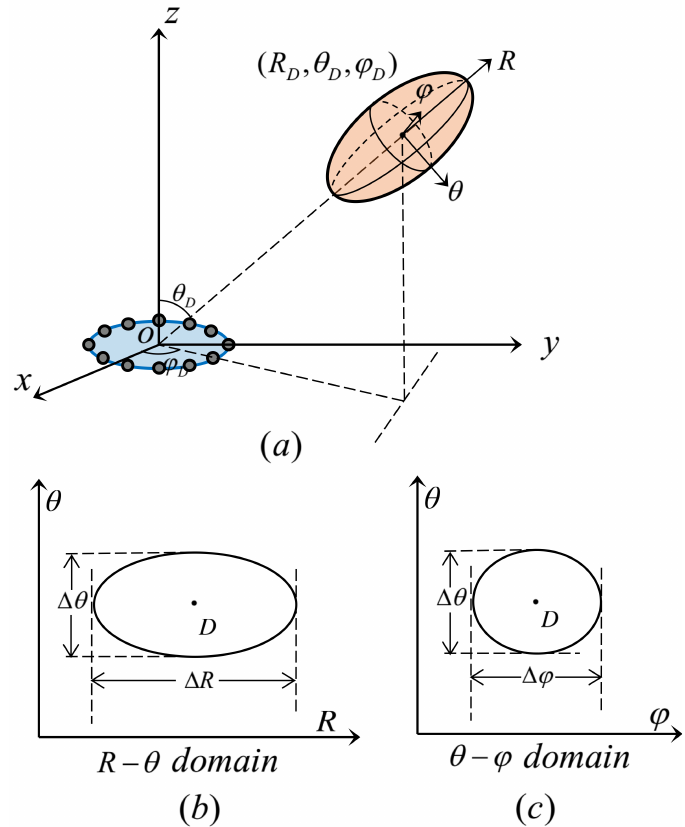
Figure 2. Illustration of THz UCA near-field beam pattern. ( a ) Schematic diagram of near-field focusing effect in 3D space. ( b ) Schematic diagram of beam pattern in R − θ domain. ( c ) Schematic diagram of beam pattern in θ − ϕ domain.